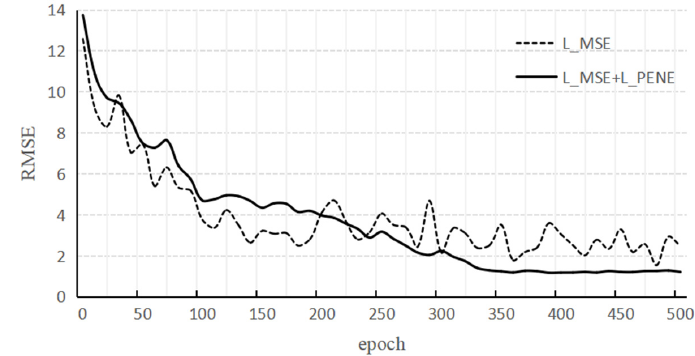
Figure 9. RMSE curve under different epochs.